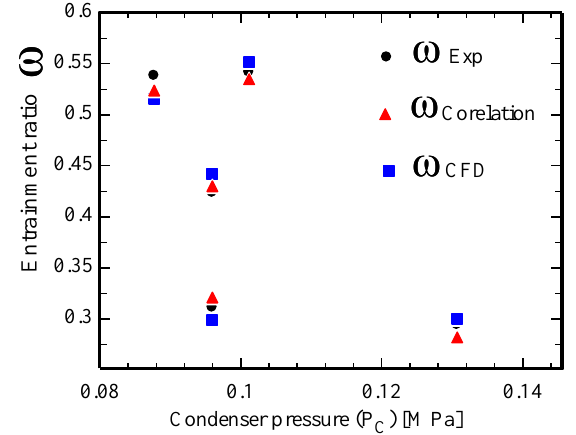
Figure 11. Validation of empirical correlation of ω through the CFD model.